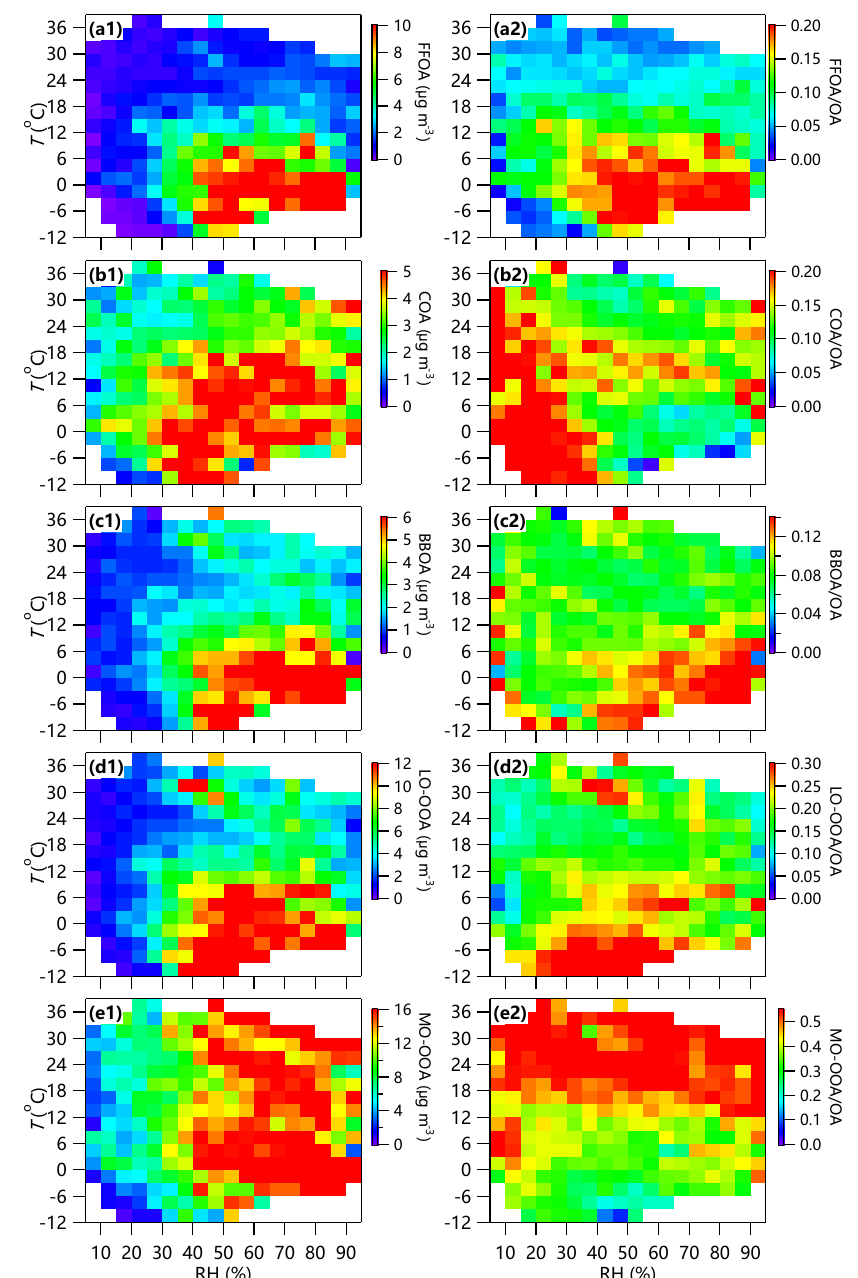
Figure 7. RH /T dependence of mass concentrations and mass fractions of five OA factors for the entire study. The data are grouped into grids with increments of RH and T being 5% and 3 ◦ C, respectively. Grid cells with the number of data points fewer than 10 are excluded.